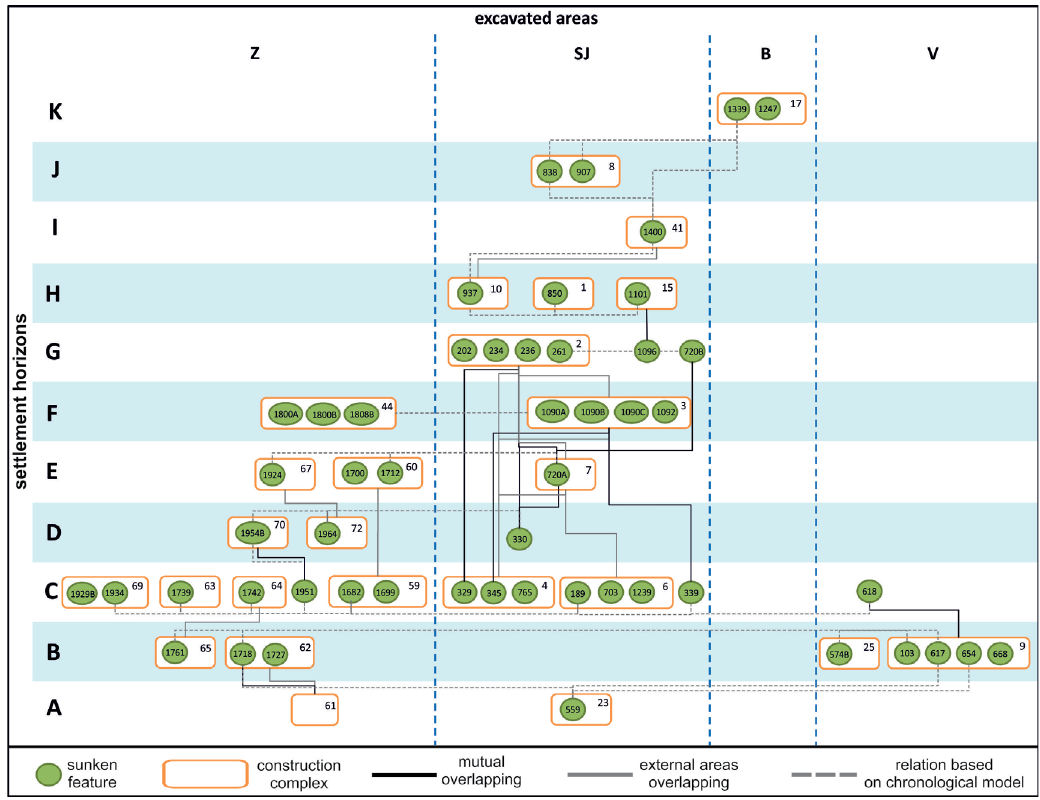
Figure 5. The second chronological model of Hrdlovka site established on the principle of Harris